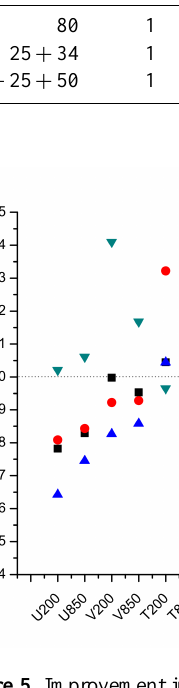
Figure 4. Taylor diagram of the climate mean state of each output variable from 2002 to 2004 of EXP and CNTL.